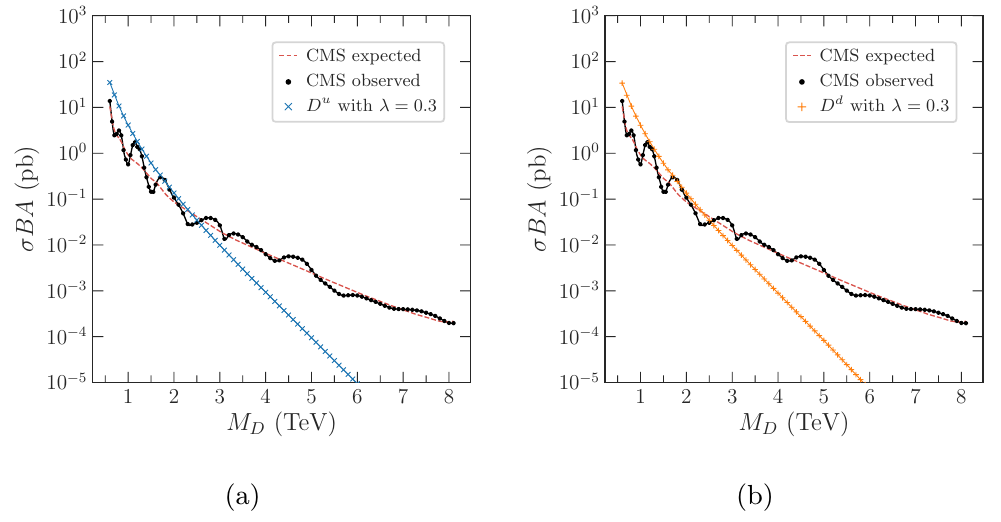
Figure 2 . Theoretical predictions of (cid:27)BA for diquarks D u (blue cross) and D d (orange plus sign), for the case where all couplings are equal and of electromagnetic strength. Observed values at 95% CL (black dots) and expected values (red dashed line) from ref. [43] are presented for